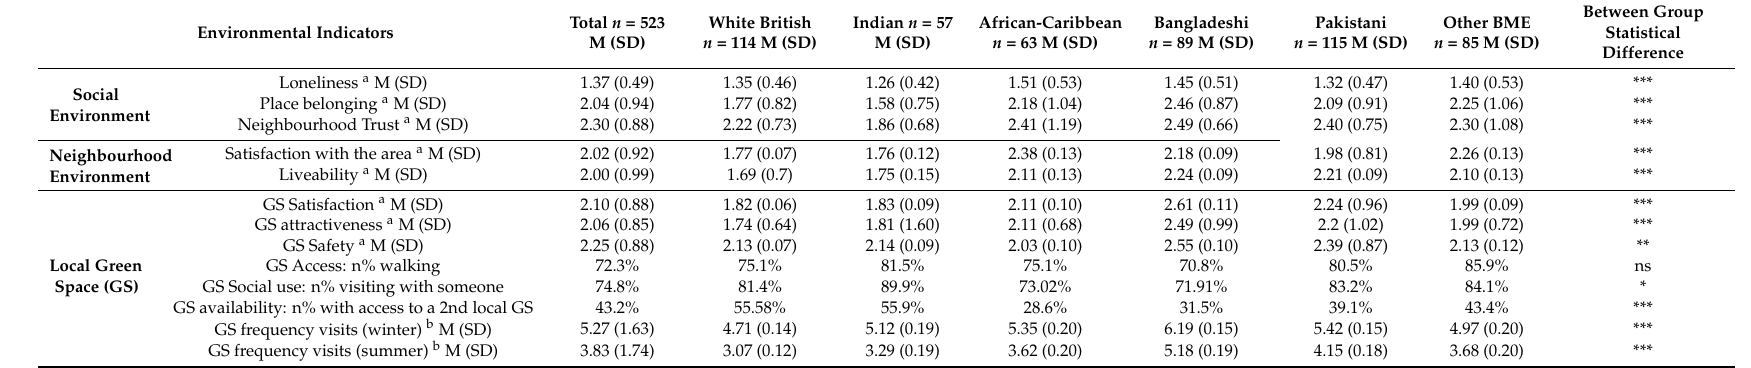
Table 2. Perceptions of place by six ethnic